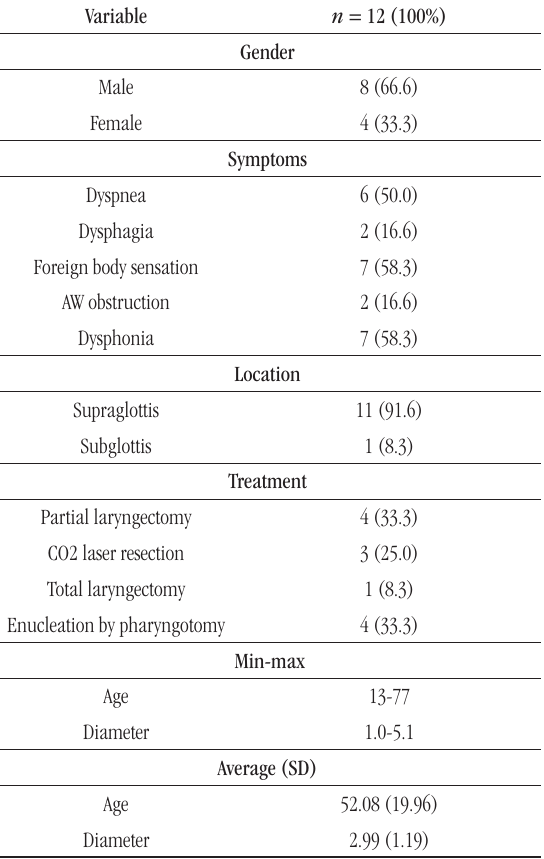
tABLE 2 – Summary of literature review